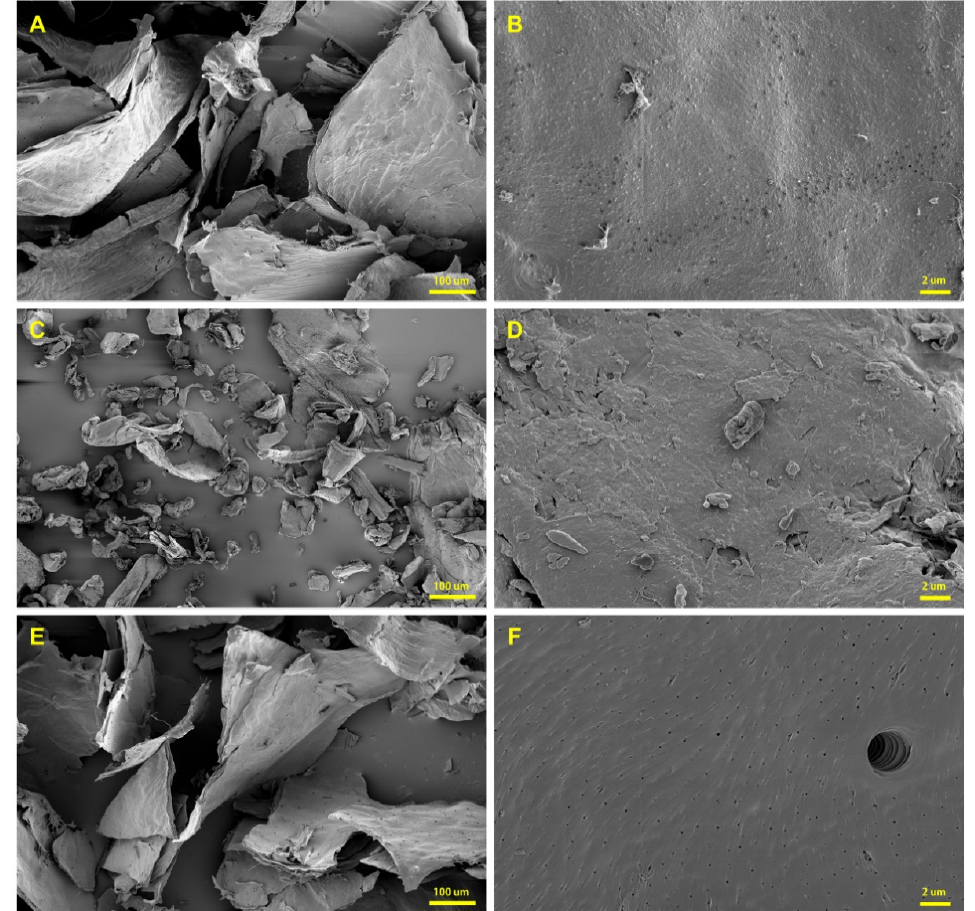
Figure 1. Field emission scanning electron microscopy (FESEM) data of chitin and chitosan samples. Images of mealworm chitin ( A , B ) (×300 and ×10,000), shrimp chitin ( C , D ) (×300 and ×10,000), and mealworm chitosan ( E , F ) (×300 and